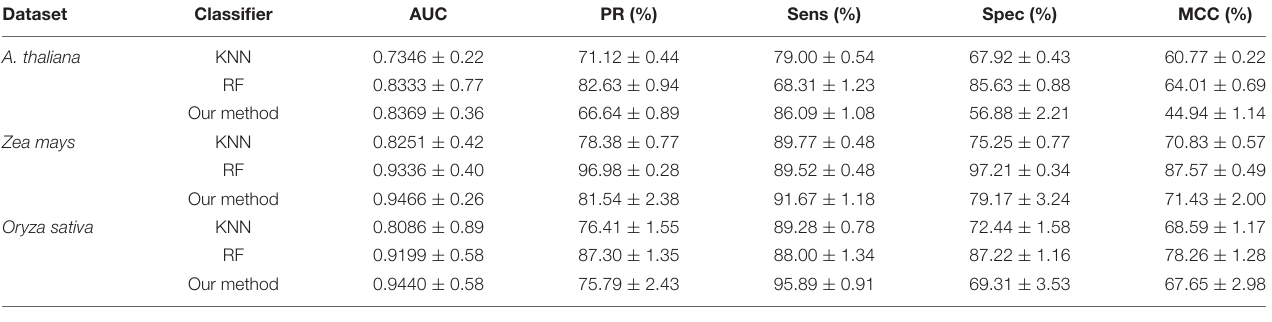
TABLE 4 | Five-fold CV results yielded by KNN and RF classifier on the three plant PPI datasets. Dataset